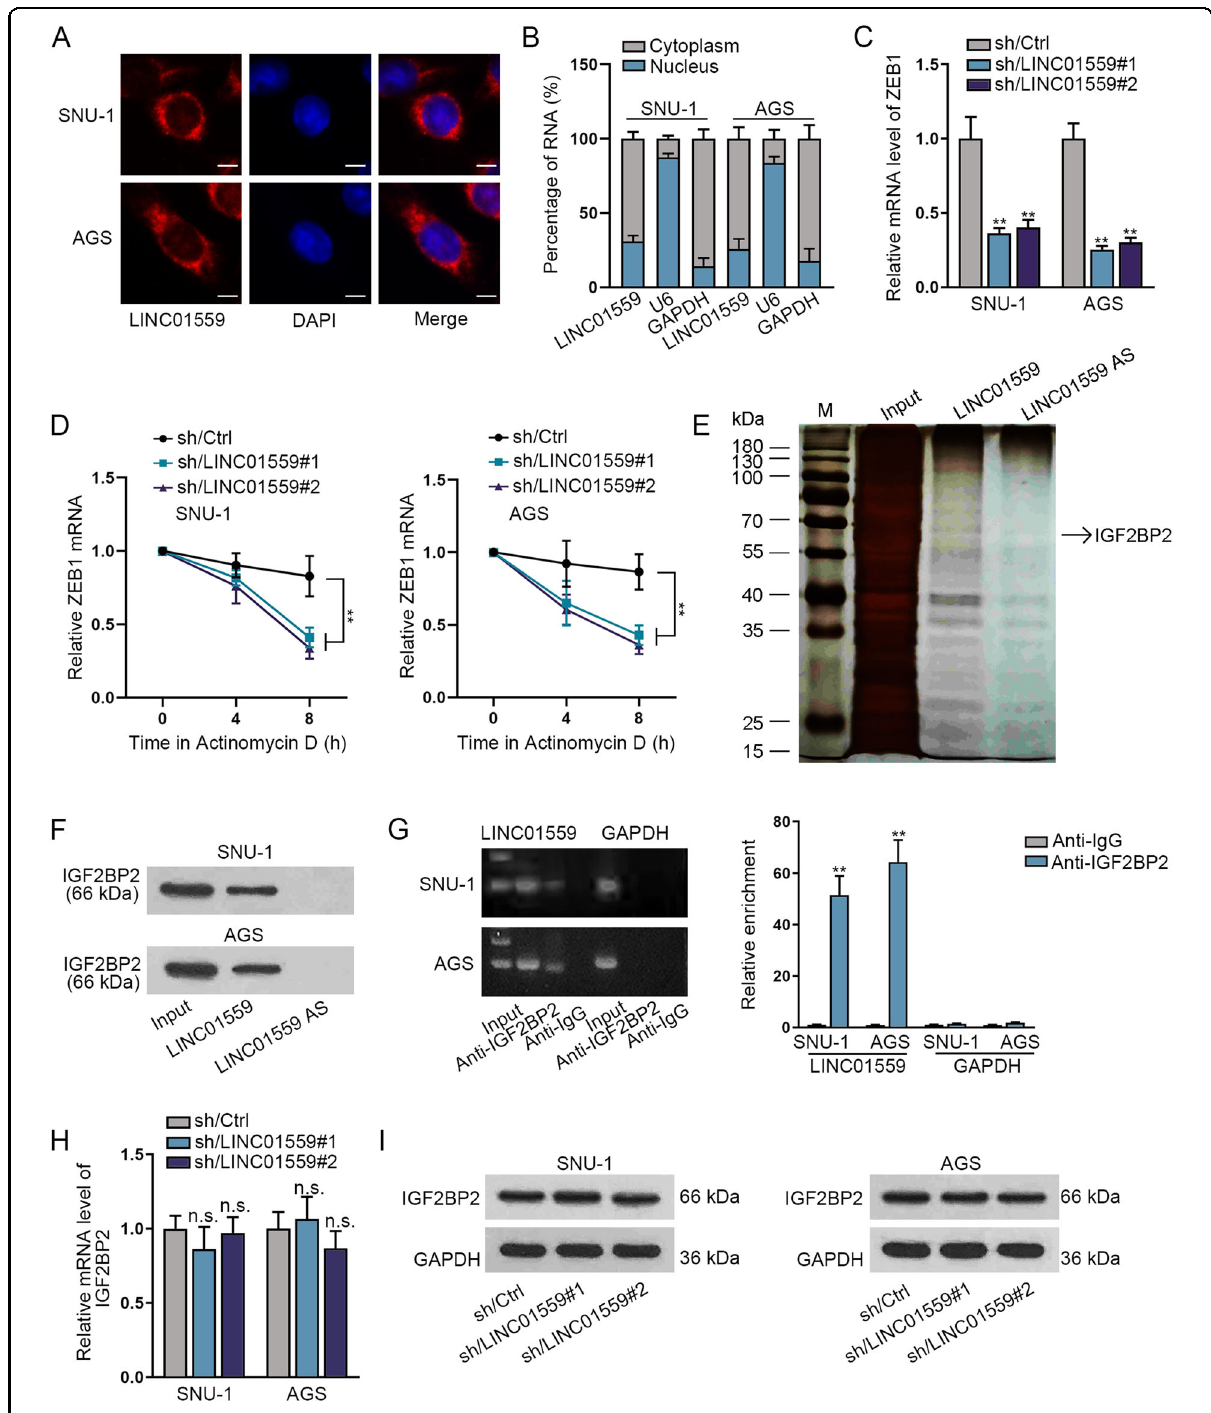
Fig. 4 LINC01559 combines with IGF2BP2 in GC cells. A, B LINC01559 mainly existed in the cytoplasm of GC cells, as detected through FISH experiment and subcellular fractionation experiment . C RT-qPCR detected the mRNA level of ZEB1 after LINC01559 silencing in SNU-1 and AGS cells. D Actinomycin D treatment followed by RT-qPCR analyzed the stability of ZEB1 in SNU-1 and AGS cells with or without LINC01559 silencing. E Electrophoretogram revealed that IGF2BP2 was a potential protein combined with LINC01559 using RNA pull-down assay and mass spectrometry analysis. F The enrichment of IGF2BP2 in LINC01559 groups of SNU-1 and AGS cells was validated through RNA pull-down assay. G RIP experiment found the content of LINC01559 in the precipitate of anti-IGF2BP2, with GAPDH mRNA as the negative control of LINC01559. H , I RT-qPCR and western blot were conducted to detect the effect of LINC01559 silencing on IGF2BP2 mRNA level and protein level. ** P < 0.01, n.s. meant no signi fi